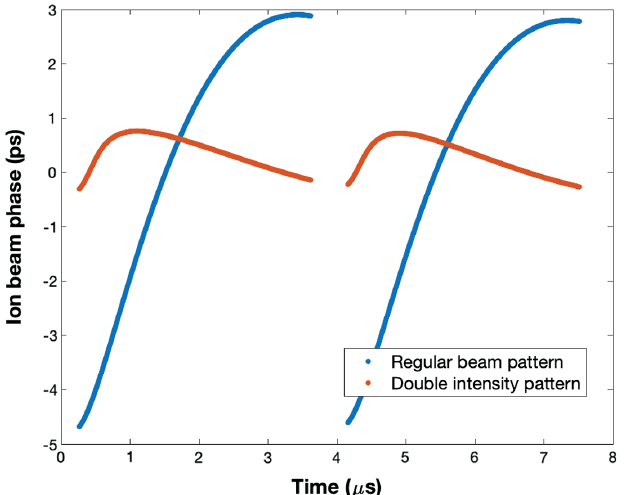
FIG. 13. Beam phase in the presence of double intensity bunches (ion